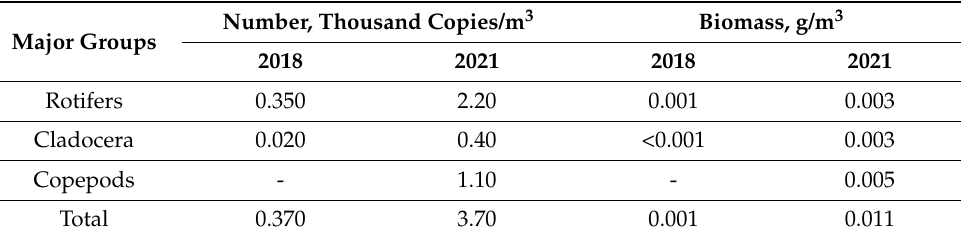
Table 2. Numerical development of zooplankton in the Tokyrauyn River (average